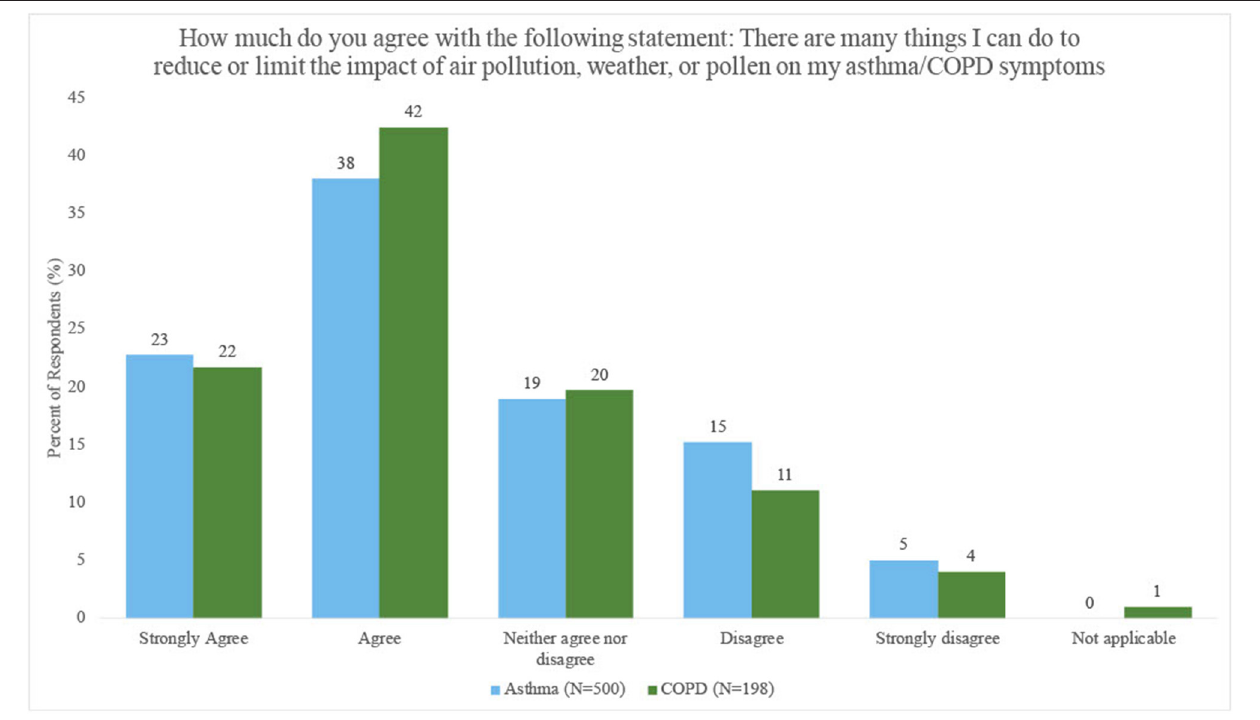
FIGURE 4 | Percent of respondents with asthma and COPD who perceived they could limit or reduce the impact of air pollution, weather, or pollen on their